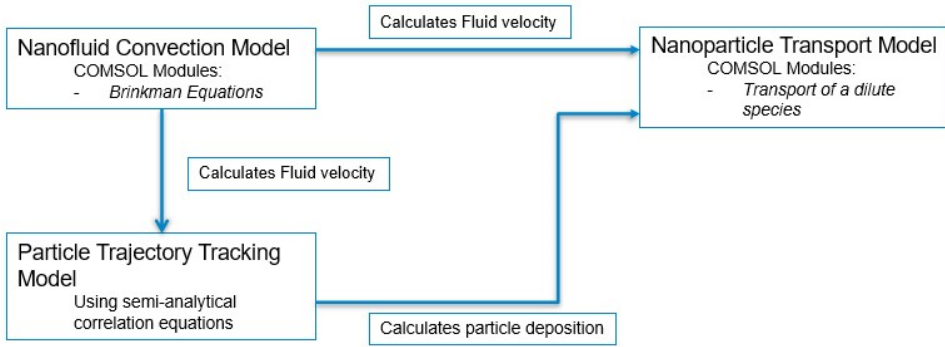
Figure 1. Schematic overview of the computational particle transport